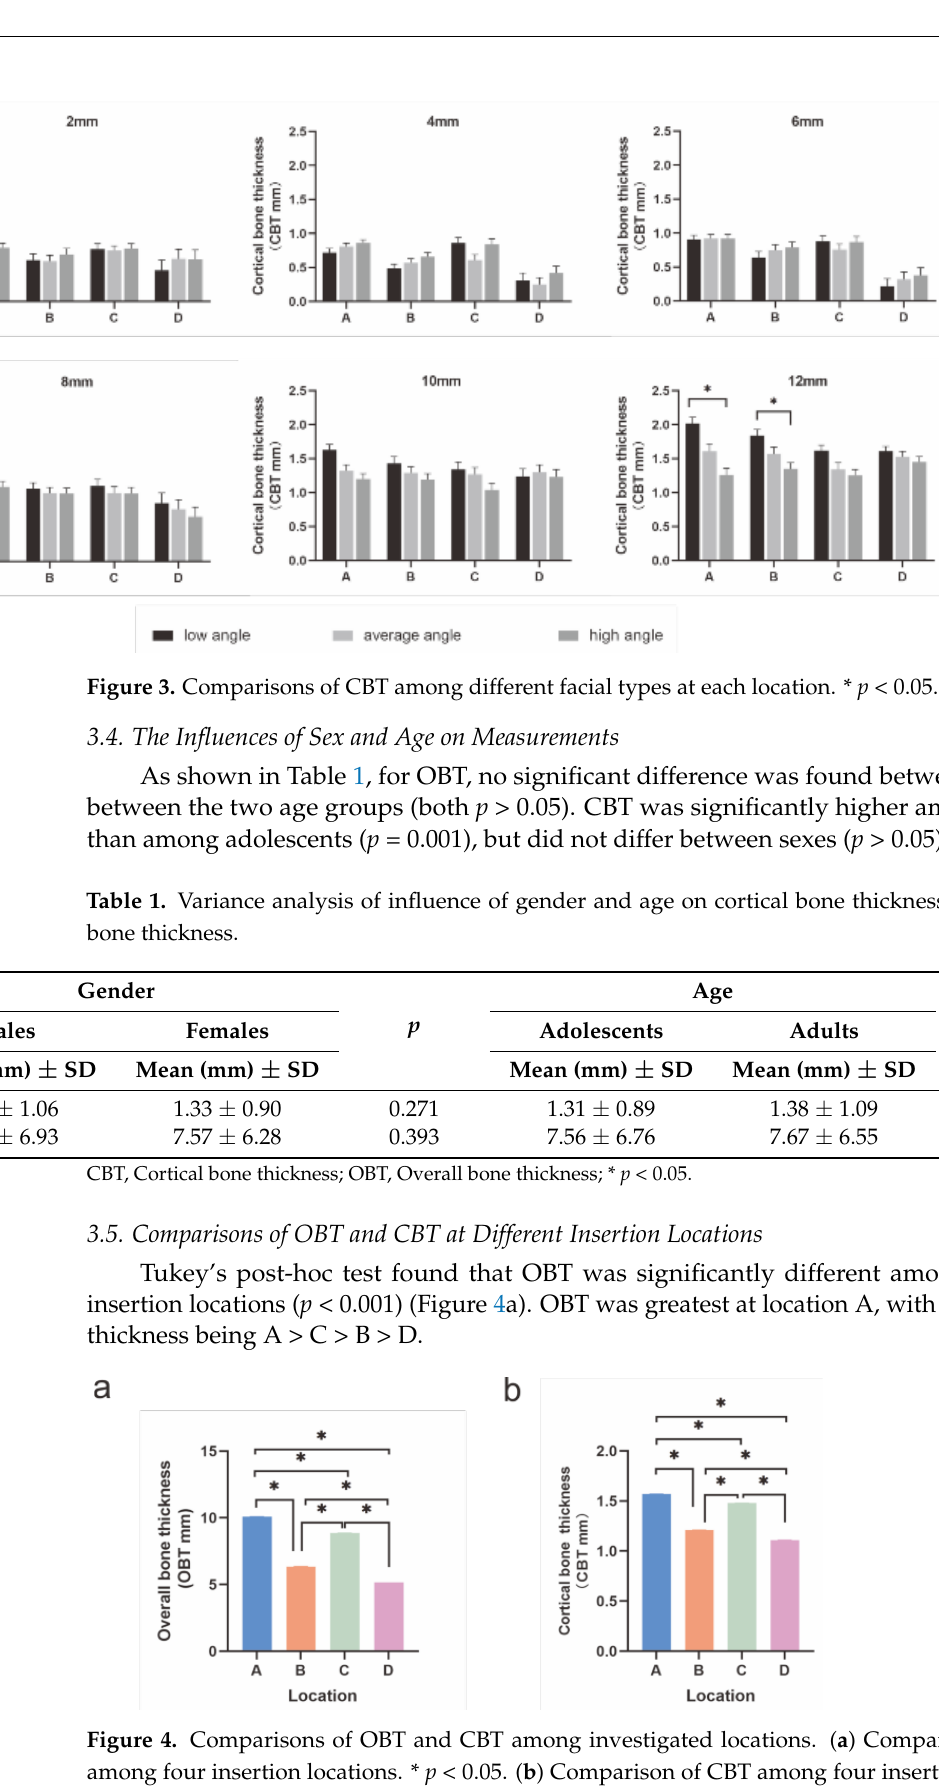
Figure 2. Comparisons of OBT among different facial types at each location. * p < 0.05.